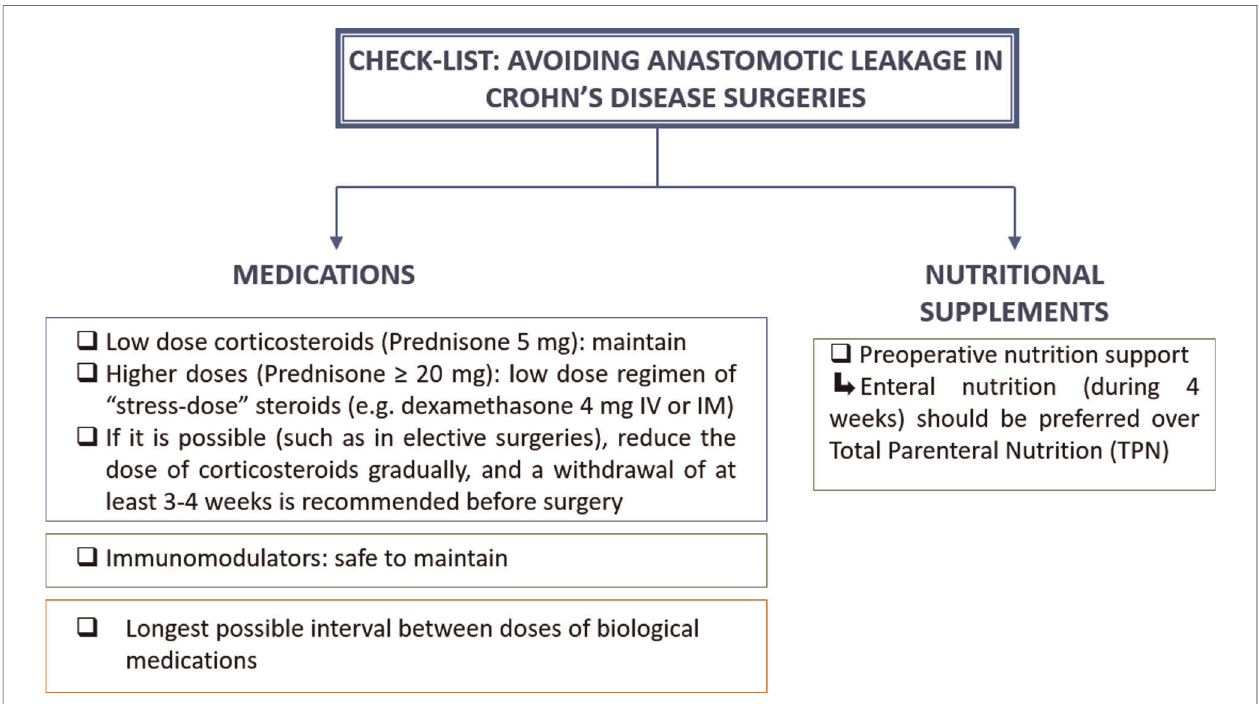
FIGURE 2 | Check-list to guide surgeons to avoid complications in Crohn ’ s disease abdominal surgeries that require intestinal resection and anastomosis.